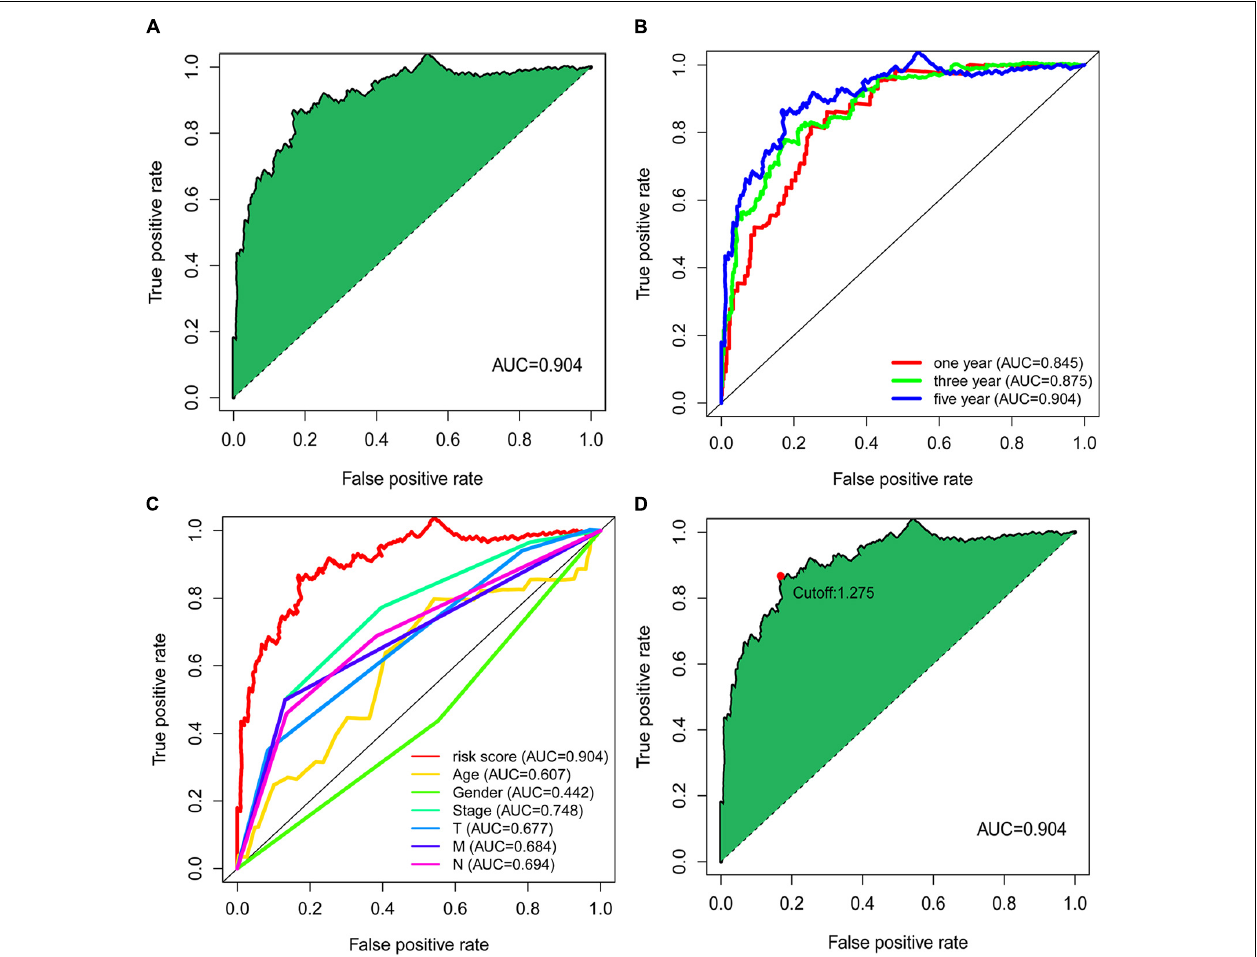
FIGURE 2 | Establishment of the signature based on DEirlncRNA pairs. (A) The 5-year ROC of the optimal signature. (B) The AUC values of the 1-year, 3-year, and 5-year ROC curves of the model. (C) The comparation of 5-year ROC curve with other clinical characteristics. (D) The risk score of 1.275 at the maximum end was taken as the cut-off value to distinguish the high and low risk of